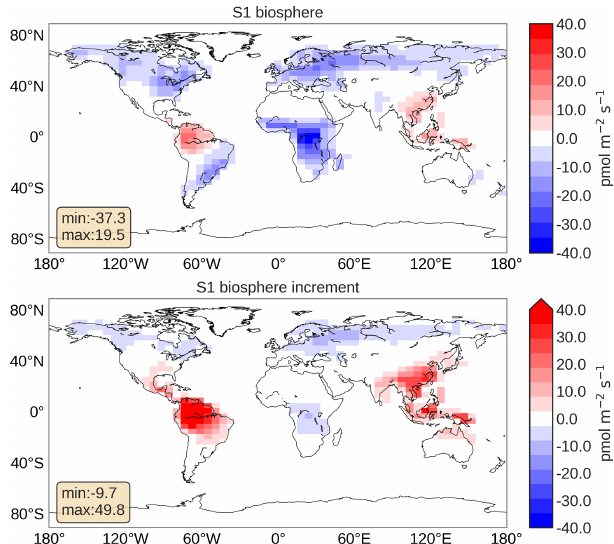
Figure 7. Posterior biosphere flux from inversion S1 and increment (posterior–prior). The fluxes represent 3-year (2008–2010) averages with removal of 6-month spin-up and spin-down periods. The max- imum and minimum flux values are given in the